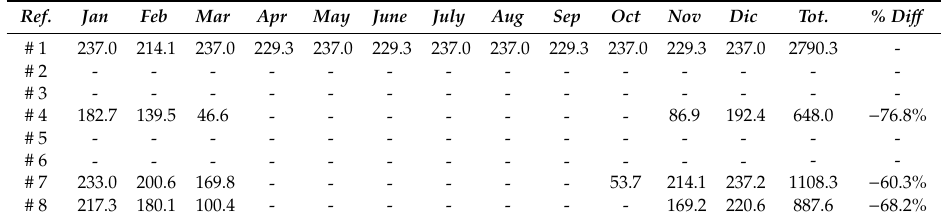
Table 4. Monthly thermal energy requirement (kWh / month) for DHW production, covered by the traditional generator.